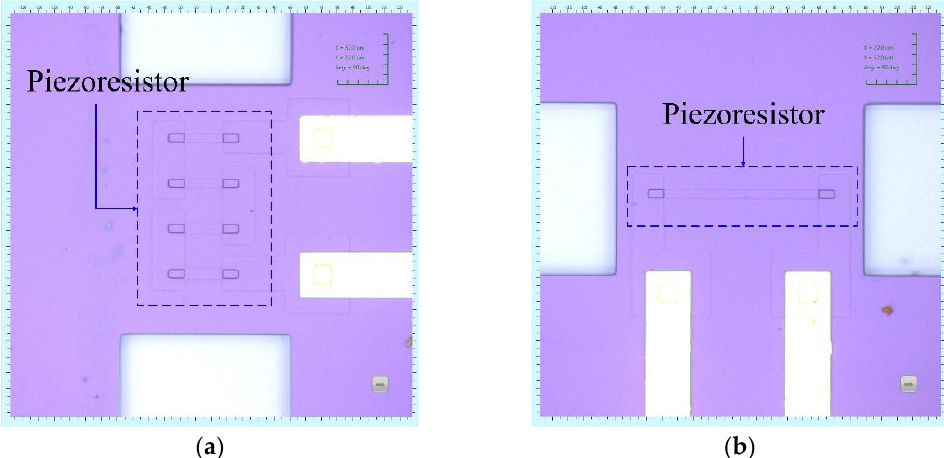
Figure A2. Microscopic photos of piezoresistors in two patterns: ( a ) piezoresistor in position 1 shown in Figure 16; ( b ) piezoresistor in position 2 shown in Figure 16.